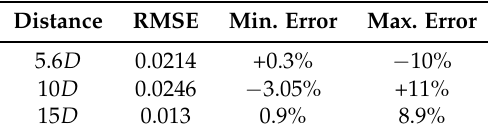
from Table 6. in